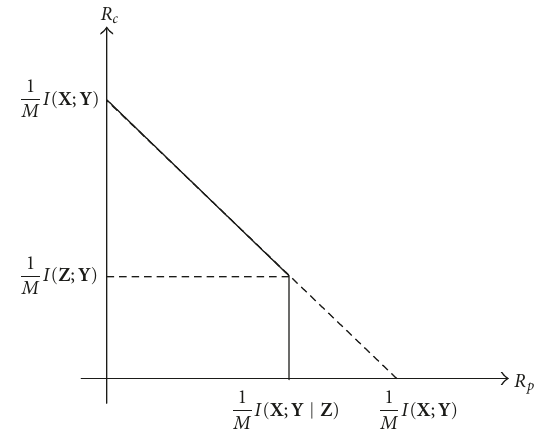
Figure 9: Region of achievable rates ( R p , R c ) in the proof of Proposition